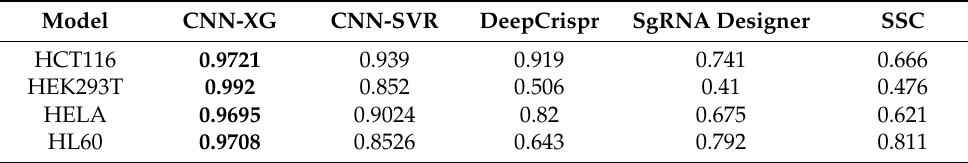
Table 3. AUROC values for test scenario 2.